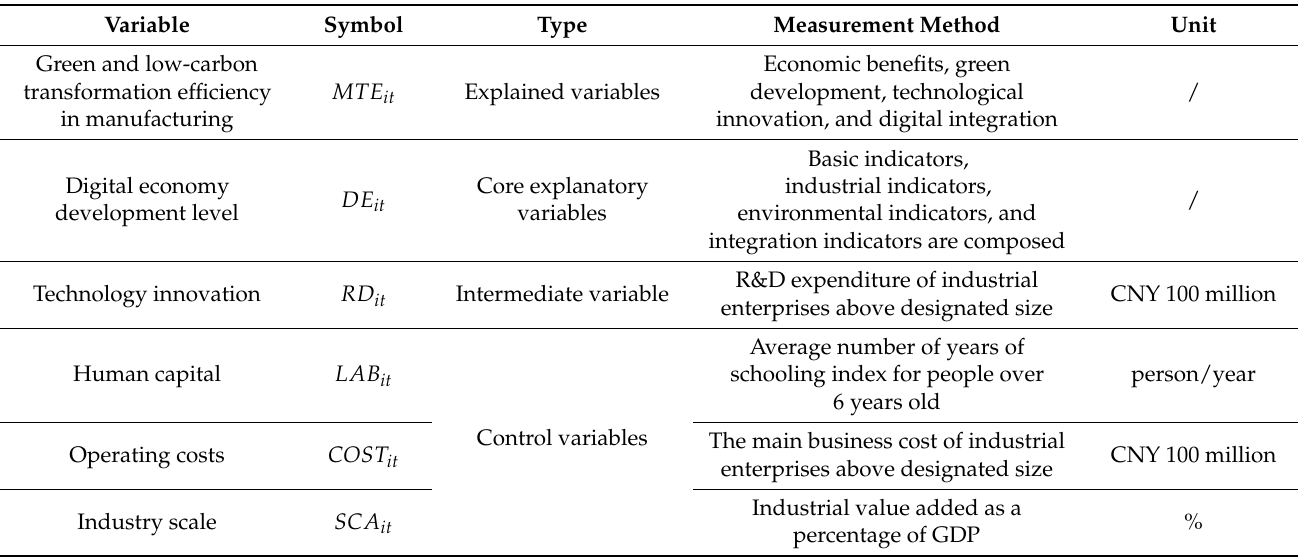
Table 5. Variables and